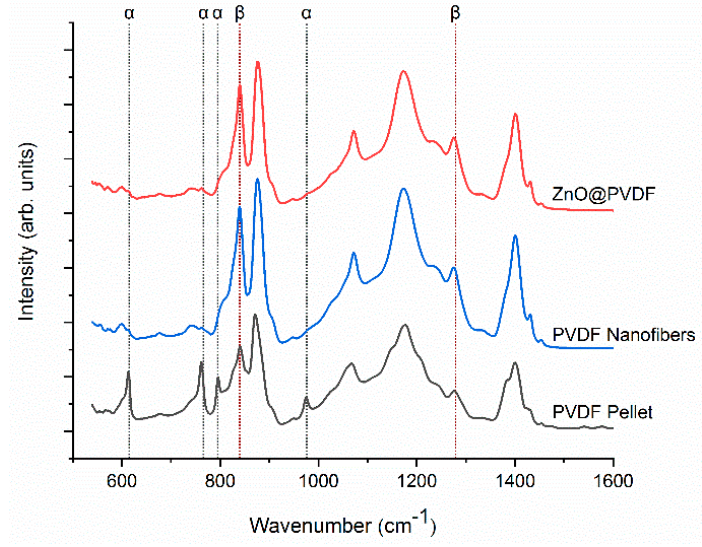
Figure 2. FTIR spectra showing the effect of electrospinning and hydrothermal growth on PVDF crystalline phases.